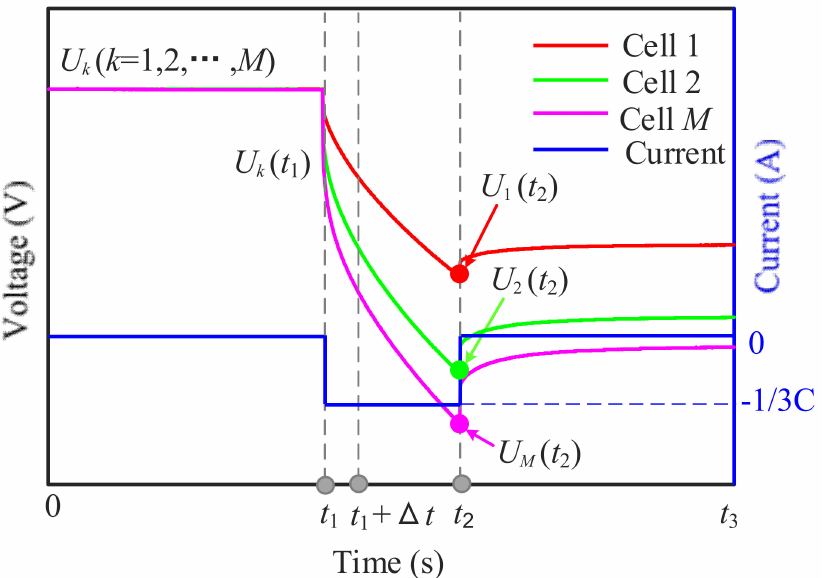
Figure 1. Screening principle based on partially discharging